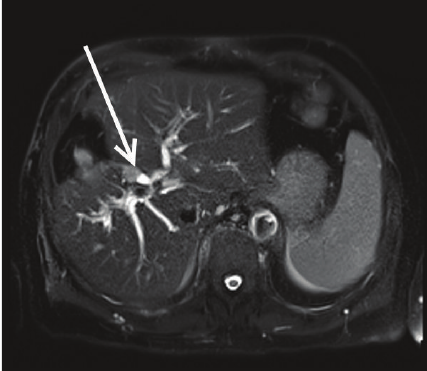
Figure 2: MRI showing the intrahepatic lesion.